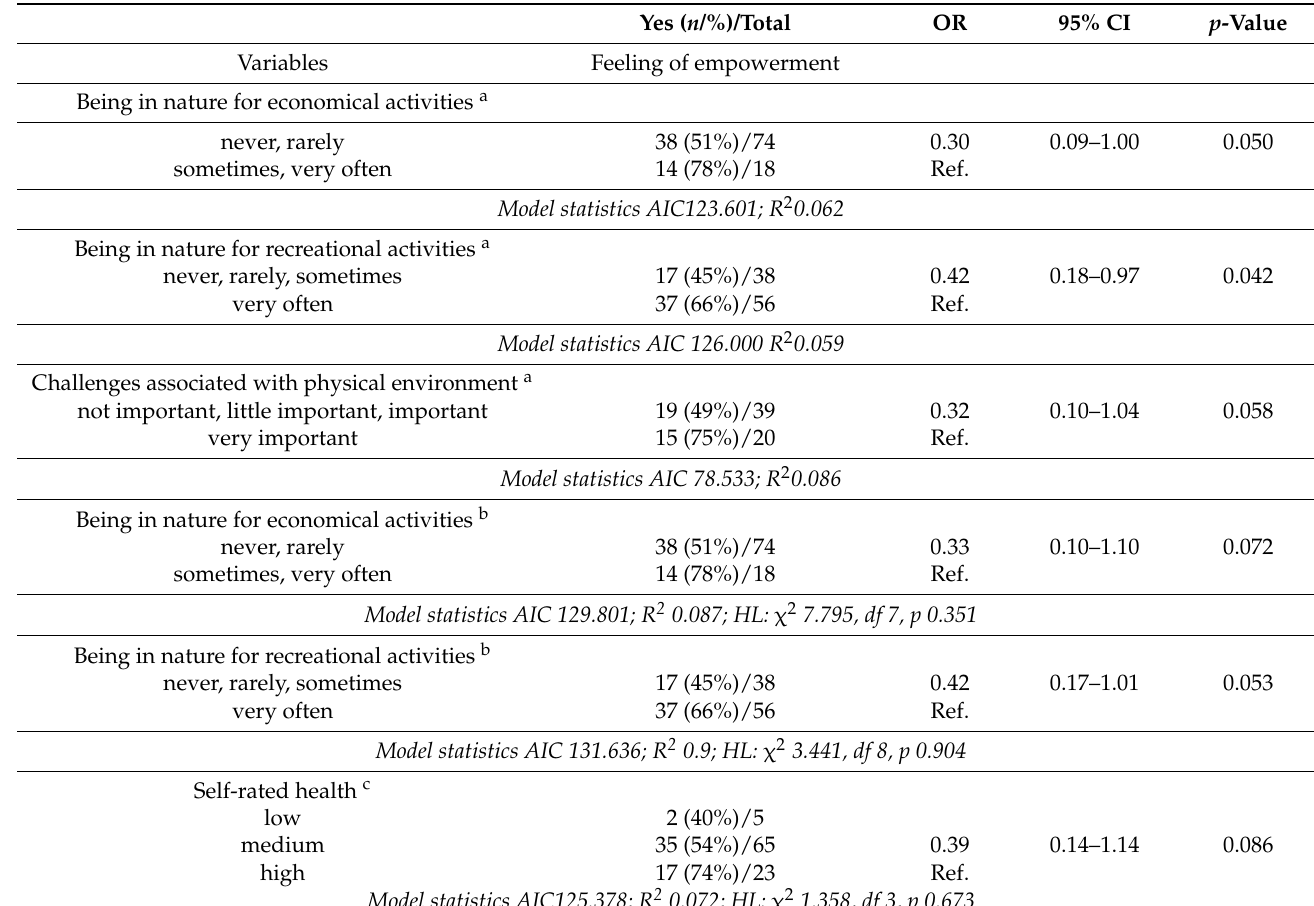
Table 3. Associations of feeling of empowerment ( p ≤